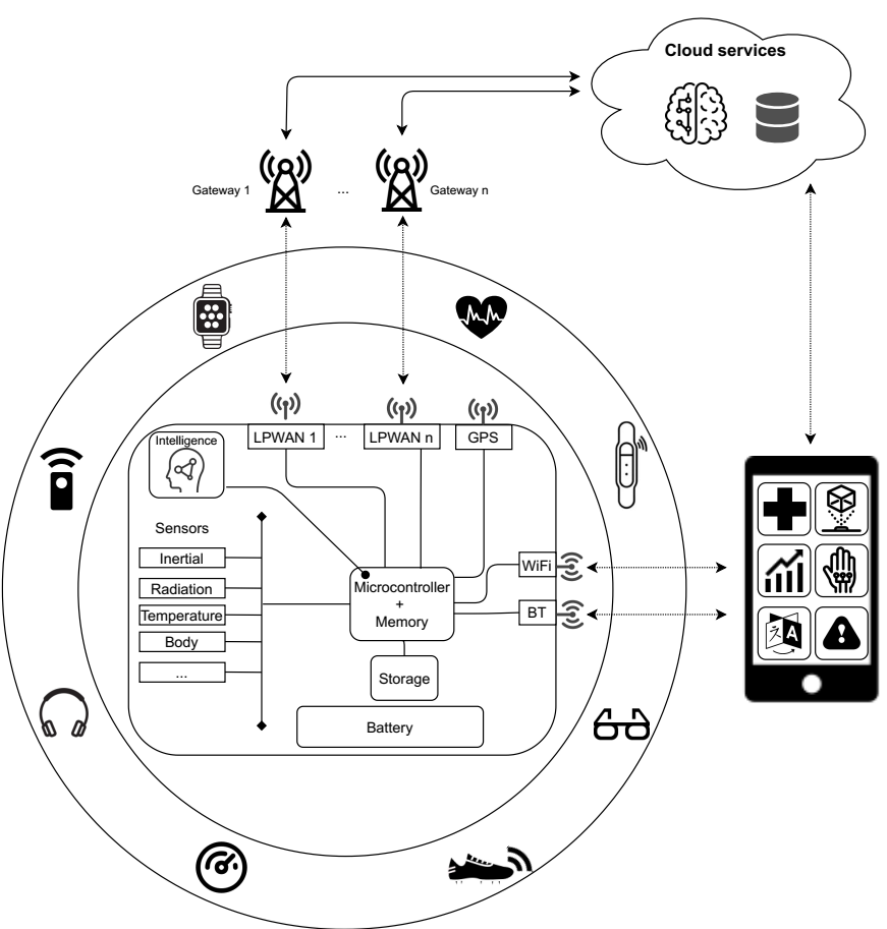
Figure 3. Wearable device architecture.